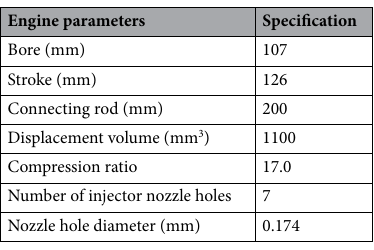
Table 1. Specification of single cylinder dual-fuel engine.